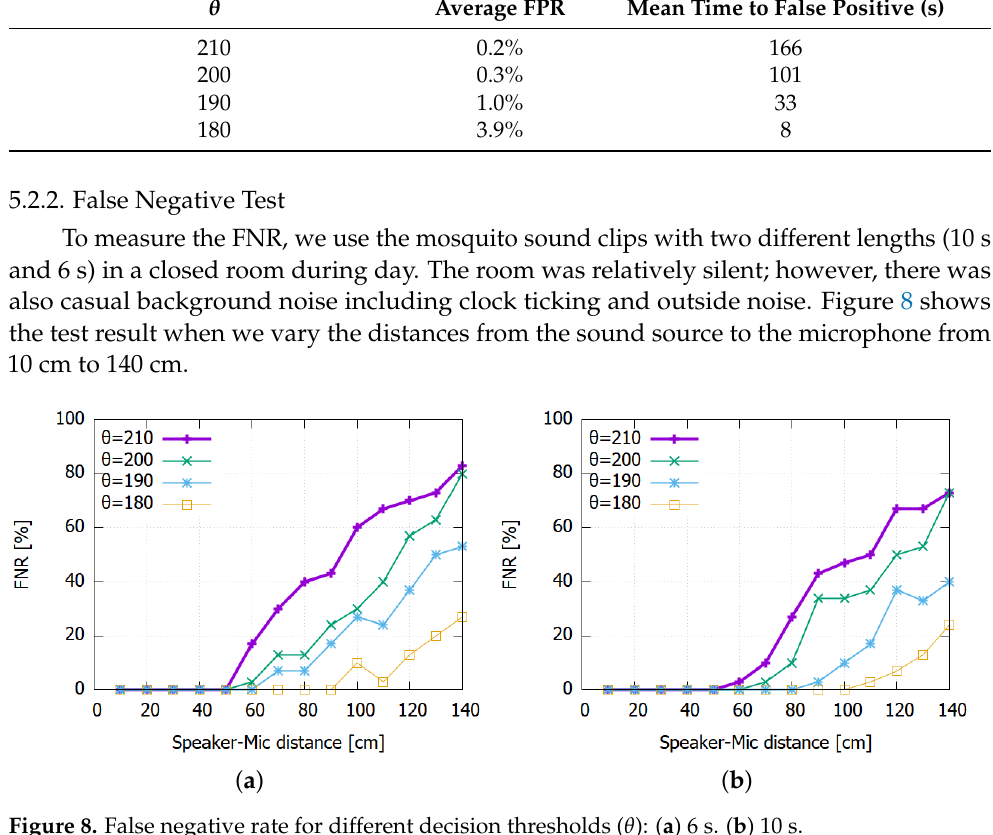
Figure 8. False negative rate for different decision thresholds ( θ ): ( a ) 6 s. ( b ) 10